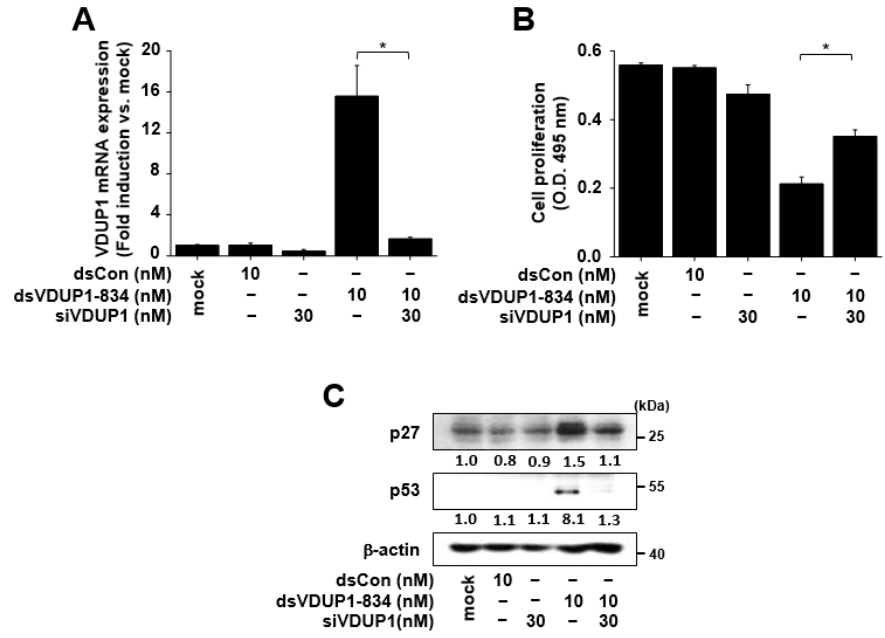
Figure 4. The effects of dsVDUP1-834 were attenuated by VDUP1 siRNA in A549 cells. A549 cells were transfected with dsCon, dsVDUP1-834 (10 nM) or siVDUP1 (30 nM) for 96 h. ( A ) The mRNA expression of VDUP1 was analyzed by qRT-PCR. Data are represented as mean ± S.D of triplicate determinations. ( B ) Cell proliferation was measured by XTT assay. Data are represented as mean ± S.D of triplicate determinations. ( C ) Protein levels of p27, p53, and β -actin in total cell lysates were determined by Western immunoblot analysis. Normalized relative intensities are shown below the bands. * denotes that the response is significantly different from dsVDUP1-834-treated group as determined by Dunnett’s t -test at p < 0.05. 2.5. Induction of VDUP1 Expression by dsVDUP1-834 Is Ago2-Dependent, and Ago2 Knockdown Alleviates the Effects of dsVDUP1-834 on Cell Proliferation and the Expression of Cell-Cycle Regulators in A549 Cells It is well-known that Ago2 is required for RNAa [2,4,15]. To investigate whether Ago2 is involved in VDUP1 induction by dsVDUP1-834, we performed a ChIP assay. As shown in Figure 5A, we detected an increased enrichment of Ago2 binding to the dsVDUP1-834 target site. To further investigate the requirement of Ago2 in the induction of VDUP1 gene expression by dsVDUP1-834, we transfected Ago2 siRNA (siAgo2) to knockdown Ago2 expression and then examined the effect of dsVDUP1-834 on VDUP1 mRNA expression. As shown in Figure 5B, dsVDUP1-834 induced VDUP1 mRNA expres- sion in the absence of siAgo2. However, induction of VDUP1 mRNA expression by dsVDUP1-834 was abrogated by siAgo2 transfection. To investigate the involvement of Ago2 in the observed effects of dsVDUP1-834, we evaluated the effect of dsVDUP1-834 on cell proliferation and the expression of cell-cycle regulators in siAgo2-transfected A549 cells. Figure 5C shows that the inhibitory effect of dsVDUP1-834 on cell proliferation was significantly reversed by the knockdown of Ago2 expression. In addition, a dsVDUP1-834-mediated increase in the levels of p27 and p53 was also reversed in siAgo2-transfected A549 cells (Figure 5D and Supplementary Figure S6).